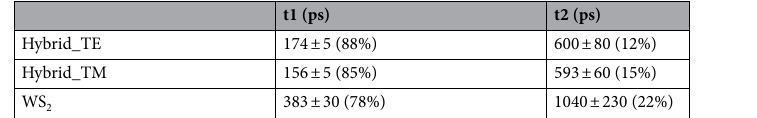
Table 1. PL lifetime of WS 2 monolayer with/without the integration of the nanowire array ( p = 600 nm, w = 170 nm). The lifetime and fractional amplitude 49 of each fitting component are displayed in the